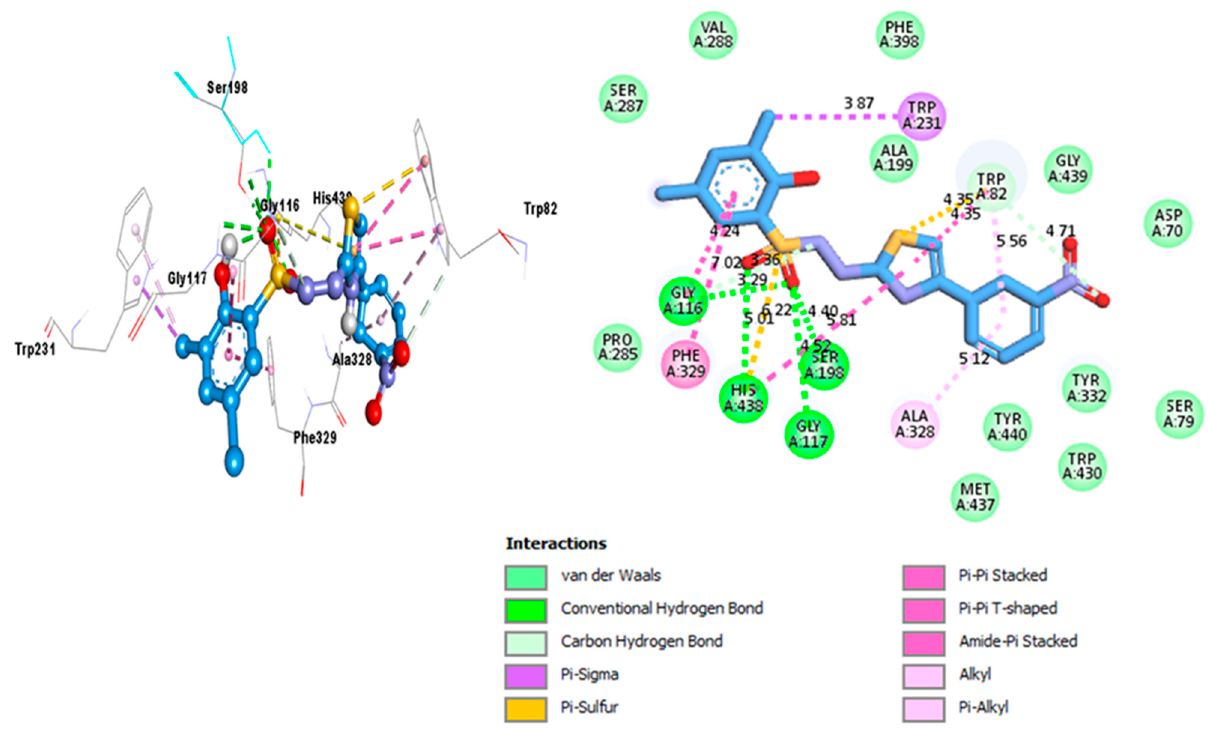
Figure 10. Representation of the PLI profile for compound 1 against BChE.